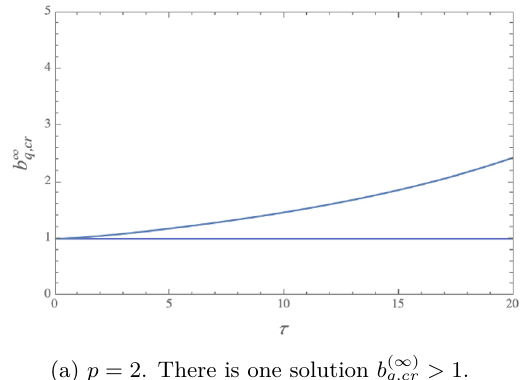
(a) p = 2 . There is one solution b ( ∞ ) q,cr > 1 . (b) p = 1 . There are two solutions b ( ∞ ) q,cr > 2 .